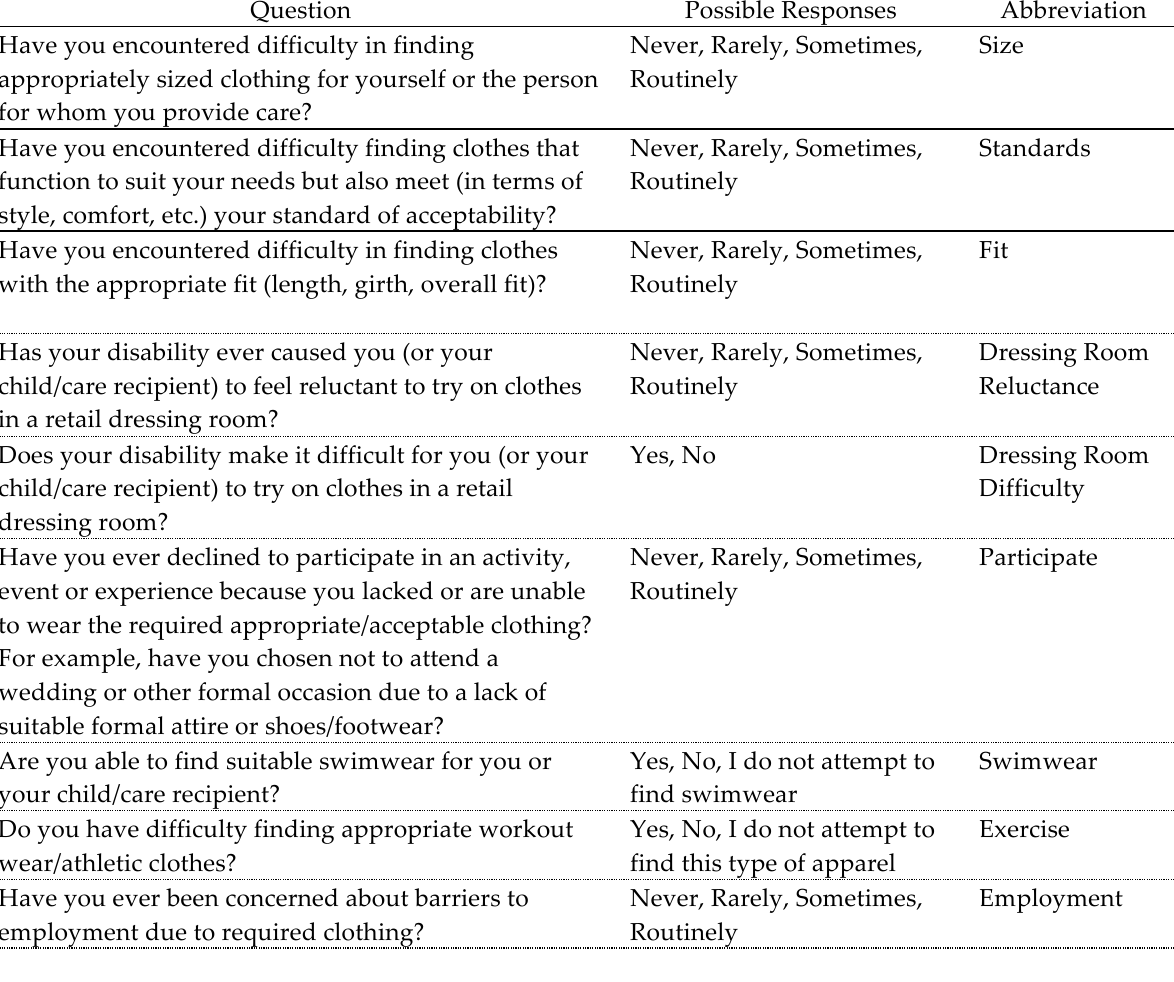
Table 2. Questions from Survey Demonstrating Age-Related Trends Question Possible Responses